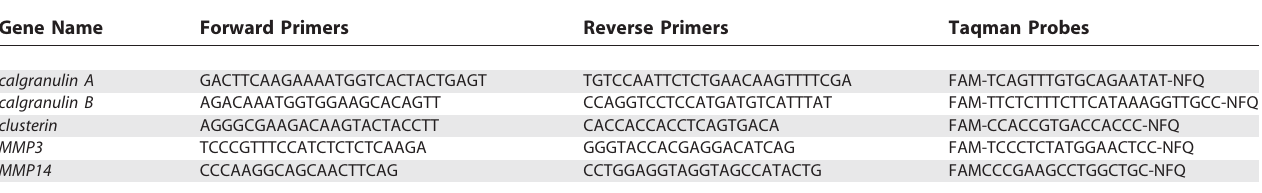
Table 1. Primer/Probe Sequences for the Taqman-Based qRT-PCR